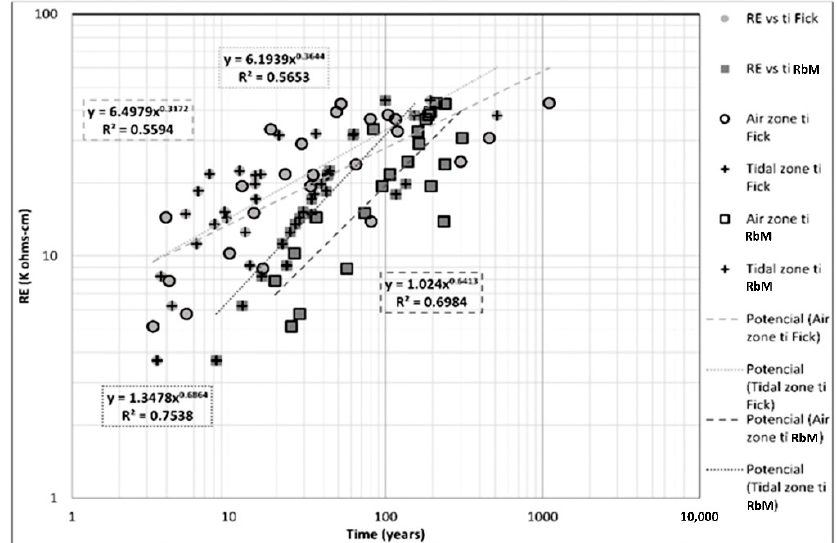
Figure 13. ER vs. t i in both zones and models.